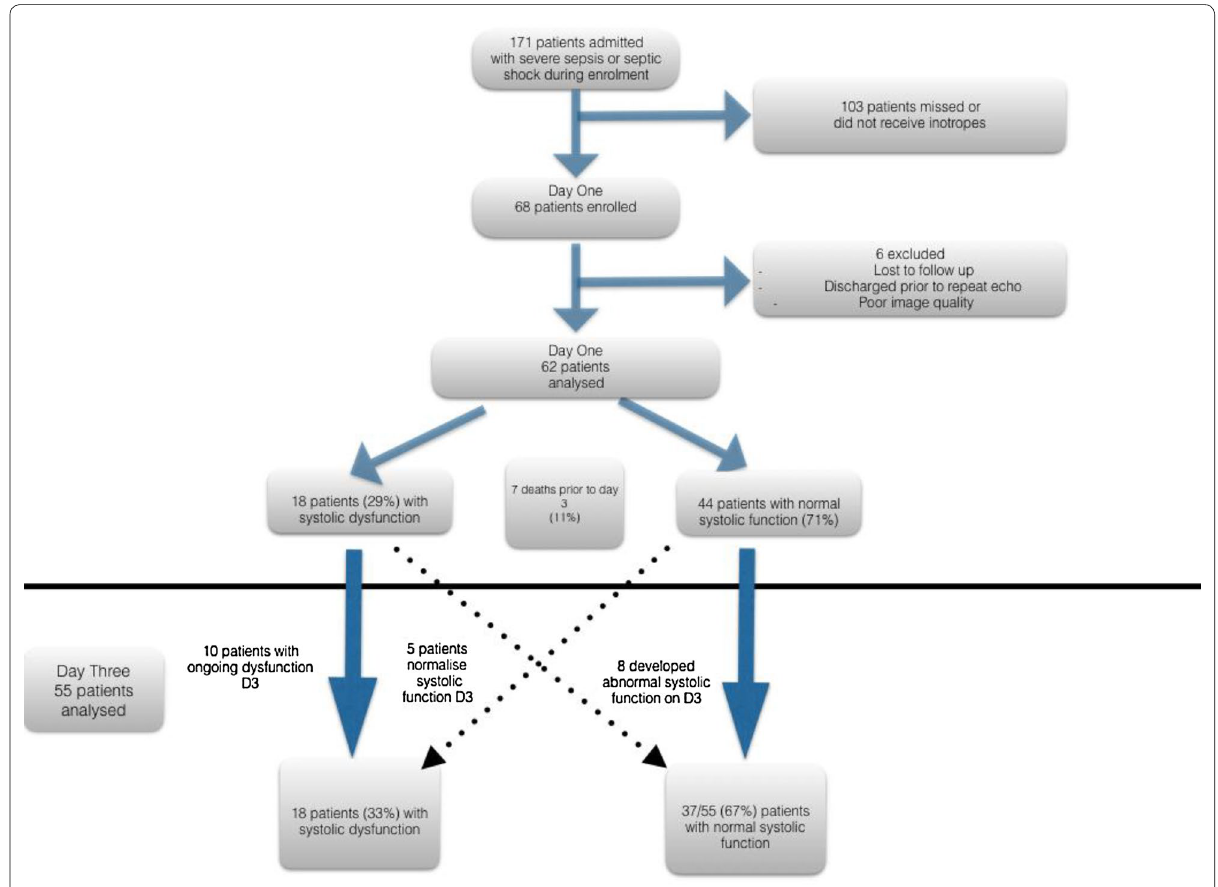
Fig. 2 Consort diagram of participants in